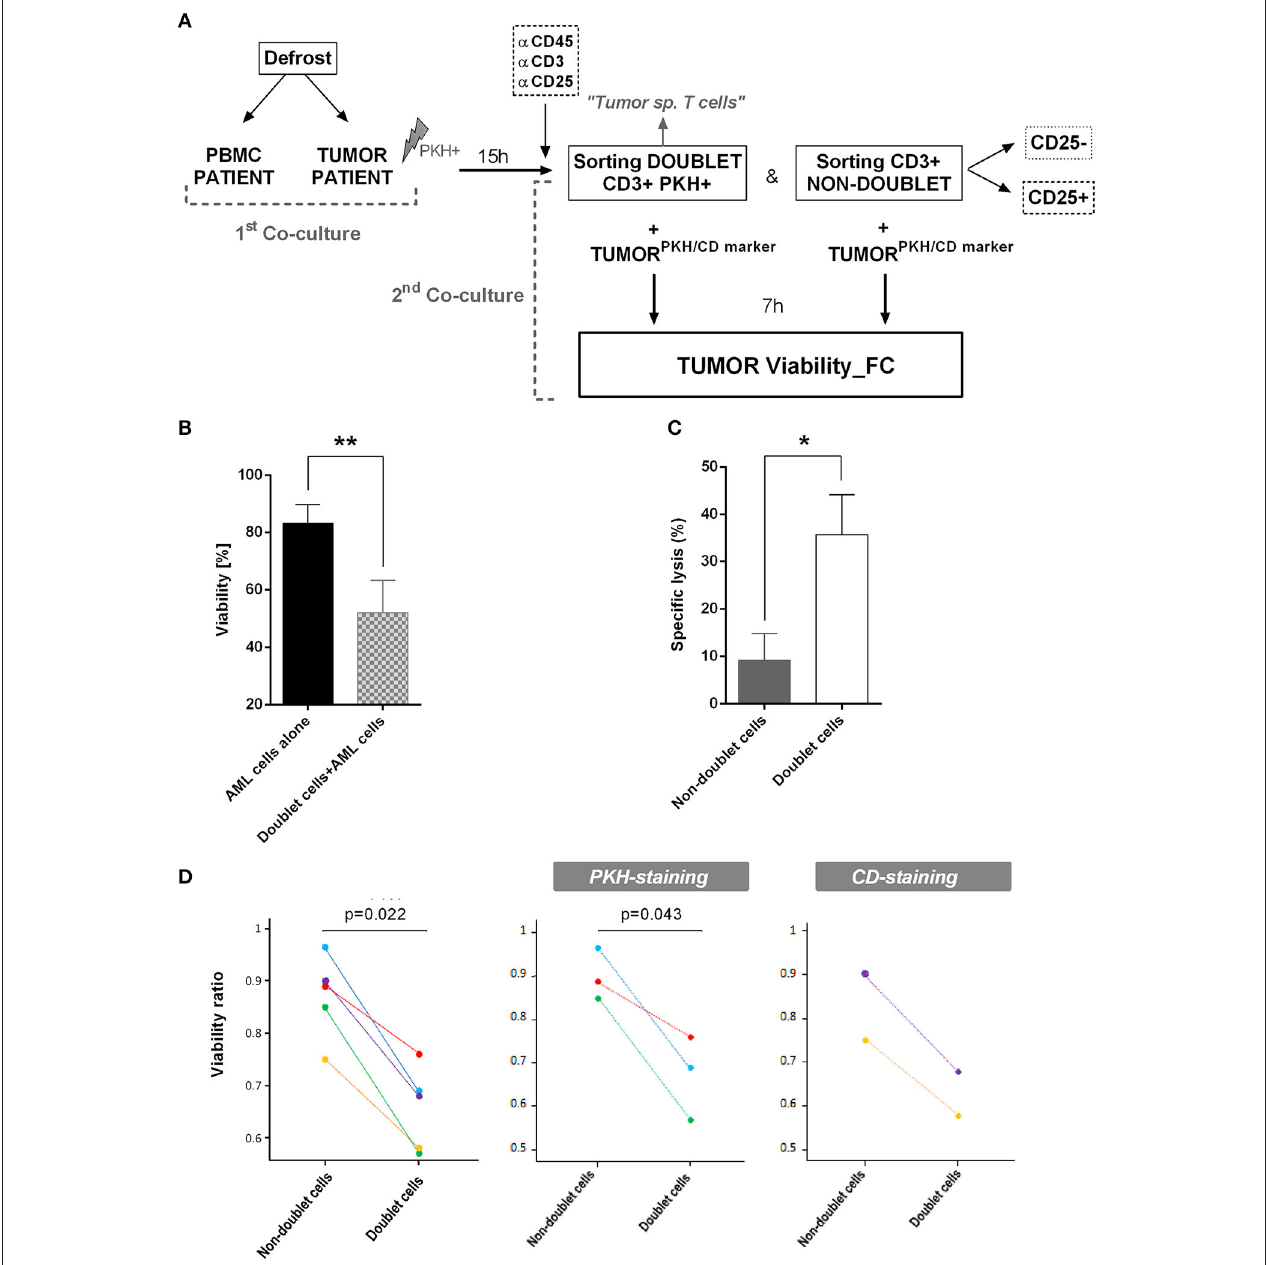
FIGURE 6 | Specific lysis of doublet-forming T cells against AML cells . (A) Schedule of the procedure: Tumor cells and PBMC from AML patients were obtained. Tumor cells were irradiated at 25Gy and stained with PKH-67. Co-culture of PBMC and tumor cells from the same patient was performed for 15h (first co-culture). Then, cells were stained and harvested for cell sorting. The sorted populations (CD3 + PKH + and CD3 + PKH–) were rested overnight. Autologous tumor cells were stained with PKH-67 or specific tumor CD markers. Secondary co-cultures between doublet-forming T cells or non-doublet T cells with tumor cells from the same patient were performed (second co-culture). After 7h, cells were collected and stained with 7AAD and Annexin V for cytometry analysis. (B) The bar diagram shows the viability of AML cells alone or co-cultured with doublet-forming T cells. Data show mean values ± SD of five independent experiments. (C) The bar diagram shows the specific lysis of doublet-forming T cells vs. non-doublet T cells. The specific lysis was calculated following the next formula: [(tumor viability alone–tumor viability with doublet or non-doublet cells)/ tumor viability alone] × 100. Data show mean values ± SD of five independent experiments. (D) The diagrams show the viability ratio of all cases (PKH-staining + CD-staining, n = 5) and the viability ratio of PKH-staining cases ( n = 3) or CD-staining cases ( n = 2). The viability ratio was calculated as follows: 1-[(tumor viability alone–tumor viability with doublet or non-doublet cells)/ tumor viability alone]. P -values between the indicated groups were calculated using paired Student t -tests. * p < 0.05,** p < 0.01.